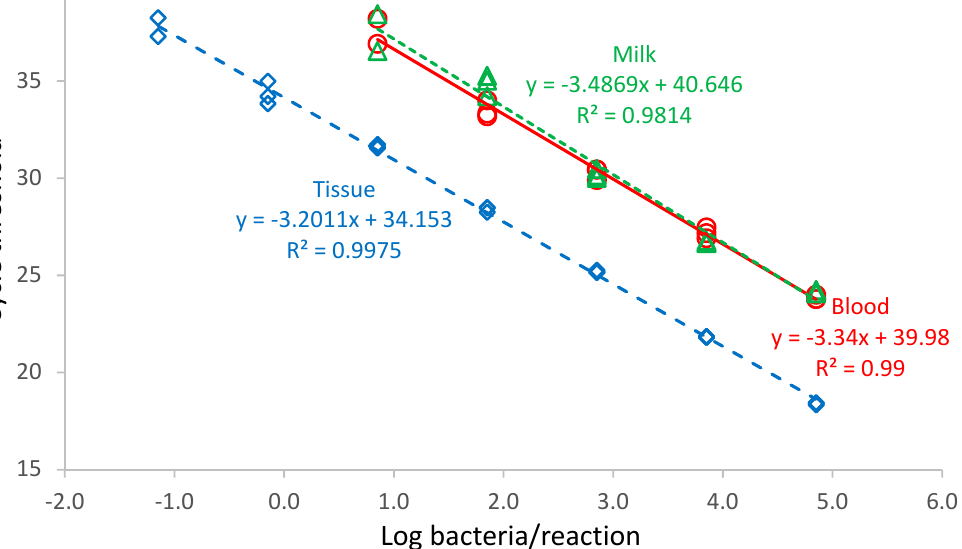
Figure 2. Standard curves of a genus-specific 16S-23S rDNA internal transcribed spacer Brucella spp. PCR assay using different matrices [i.e., blood (red circles), milk (green triangles), and tissue (blue diamonds)]. Each dilution was run in triplicate. The equation of the regression line (red line for blood, green dash for milk and blue dash for tissue) is indicated, as well as the coefficient of determination (R 2 ). One bacterium contains three copies of the 16S-23S rDNA internal transcribed spacer gene.